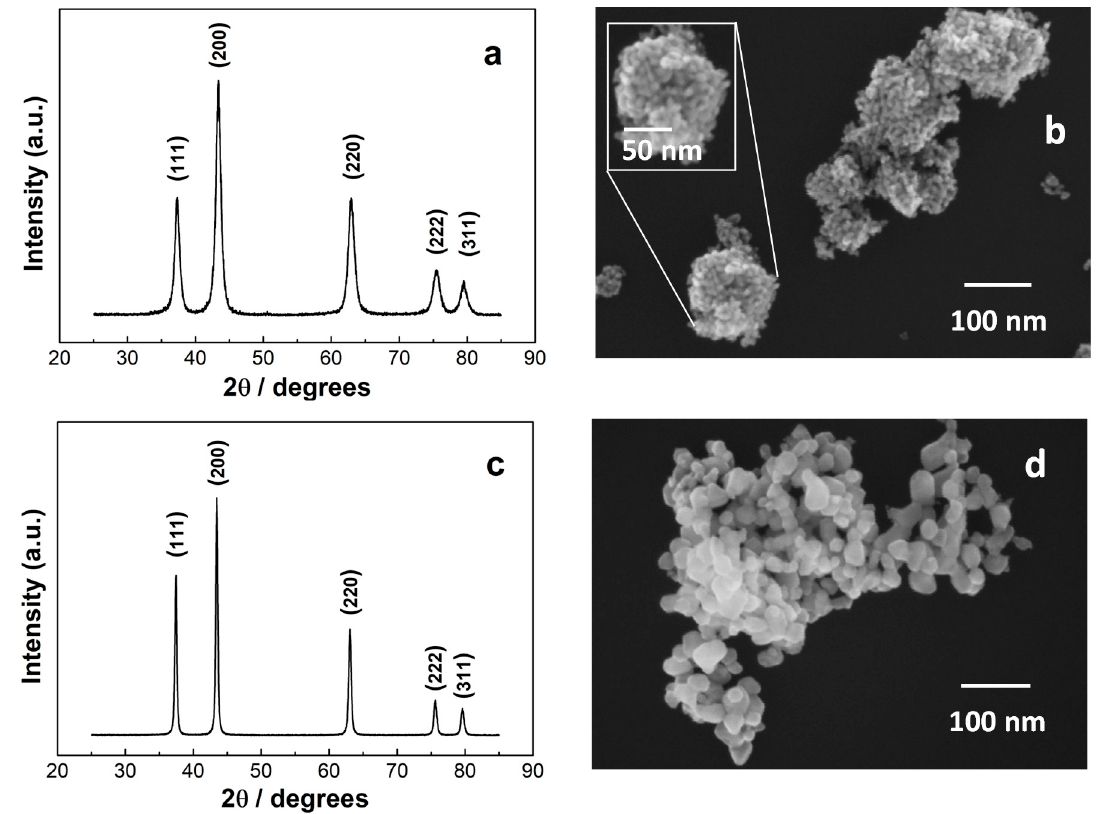
Figure 2. ( a ) XRD and ( b ) SEM image of grained-flowers NiO ( c ) XRD and ( d ) SEM images of the nanoparticles NiO. The inset in panel ( b ) is the enlargement of one of the grained-flowers.